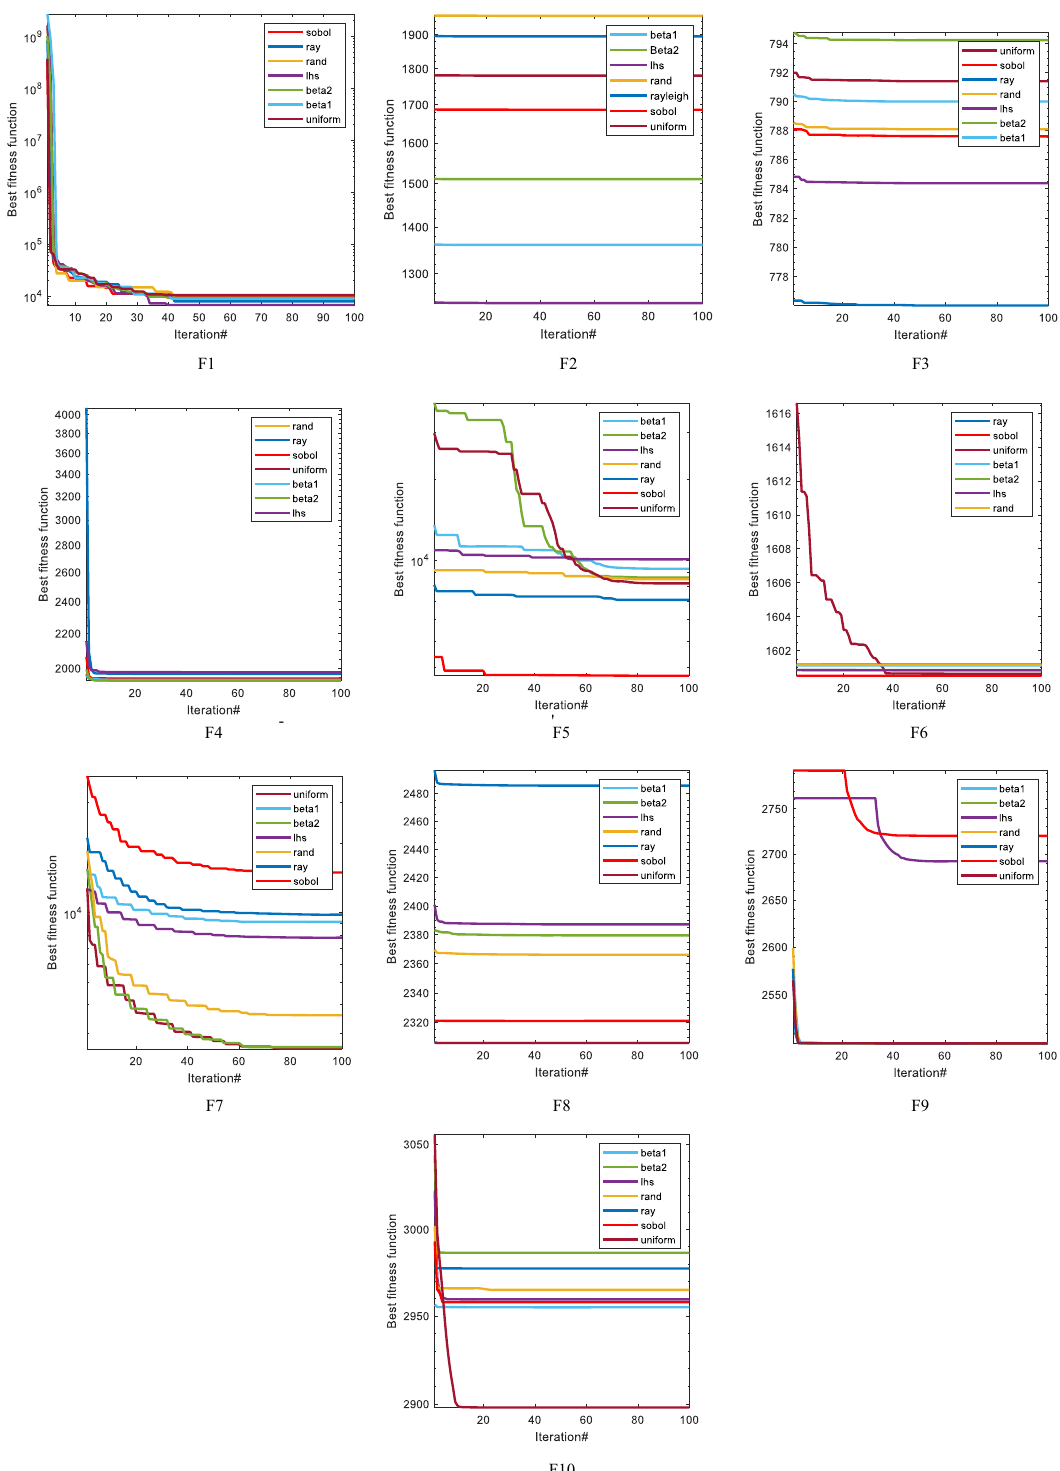
Figure 5: Convergence curves for CEC 2020 test